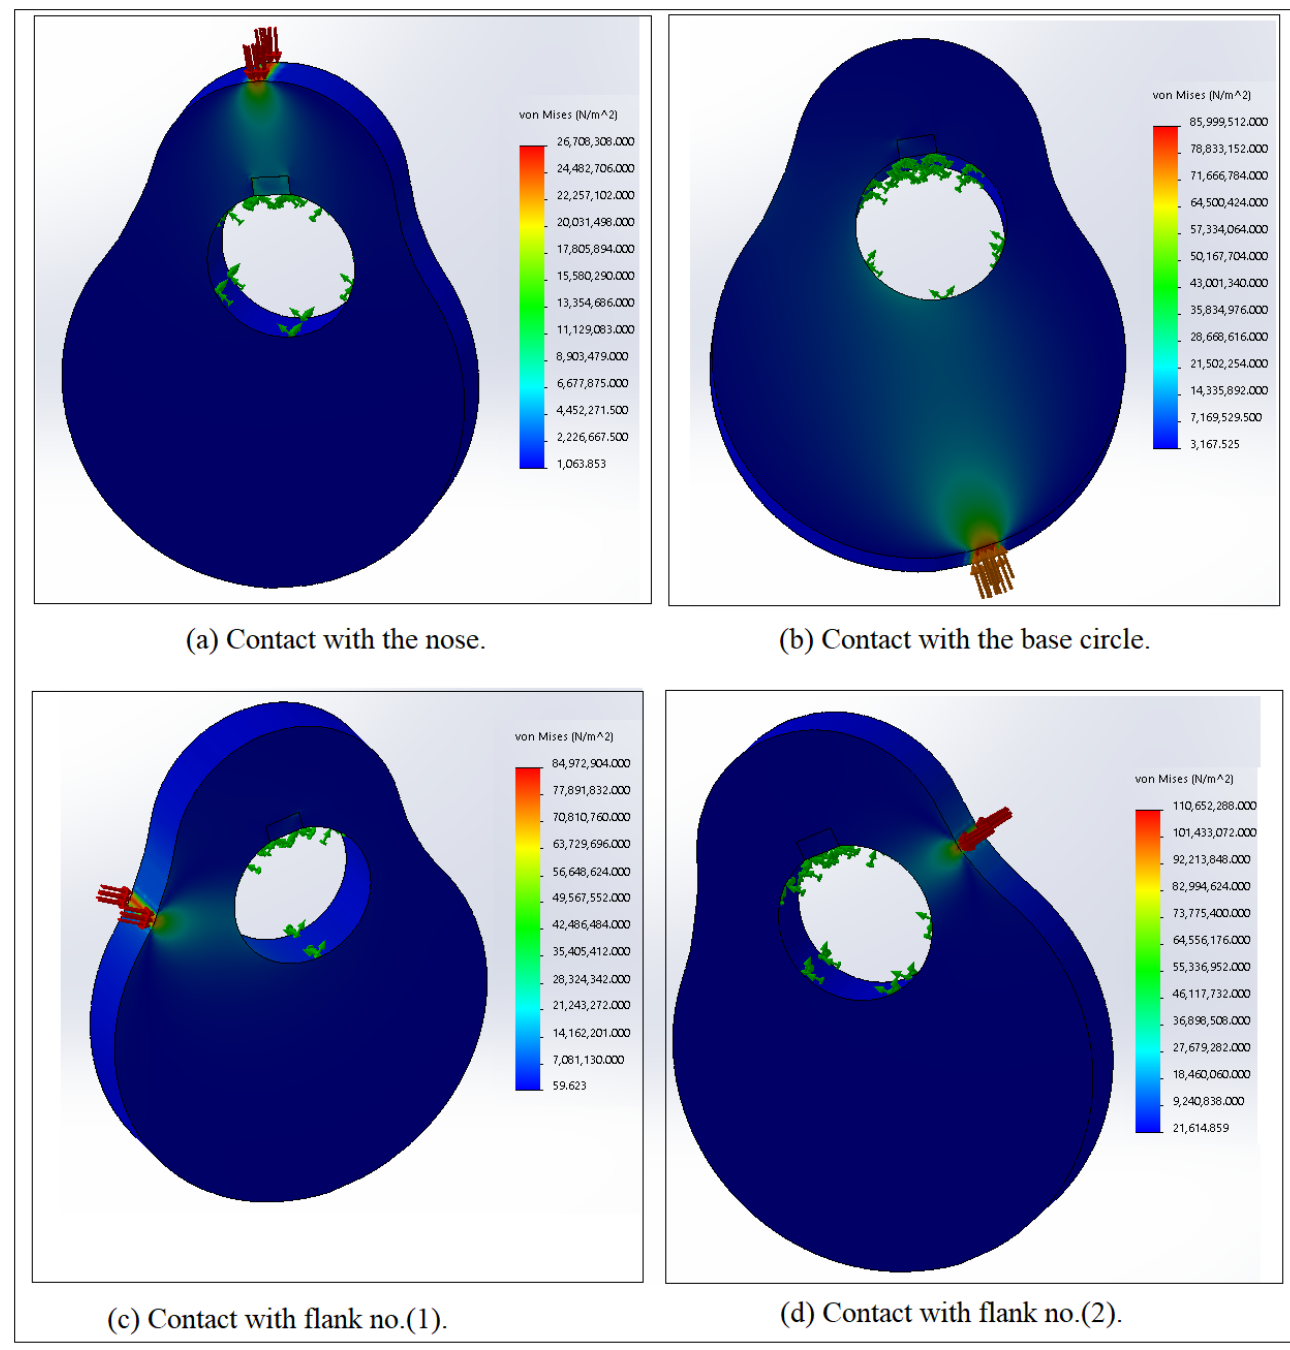
Figure 23. Von Mises stress mapping contour for profile no.(1) at different contact locations.